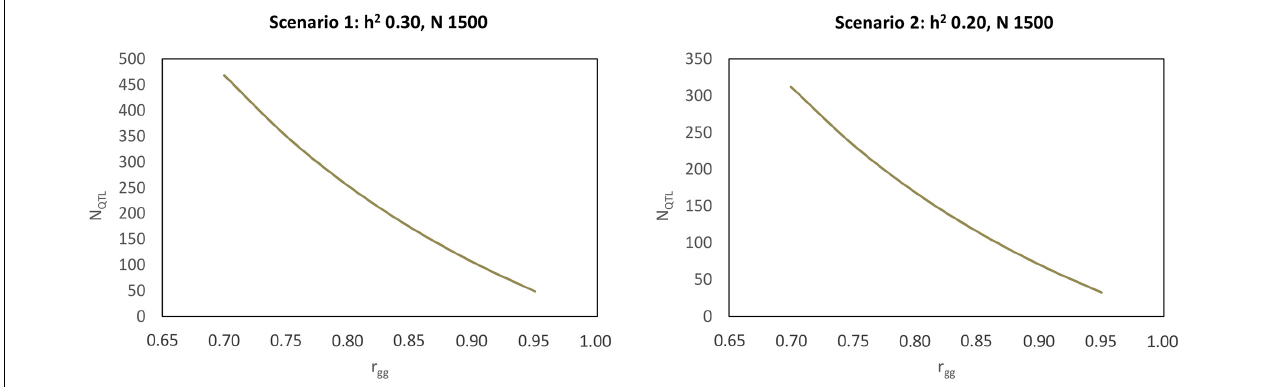
FIGURE 6 | Number of quantitative trait loci (N QTL ) for genomic selection with accuracy ranging from 0.70 to 0.95 in two scenarios in terms of heritability and individual sample size.